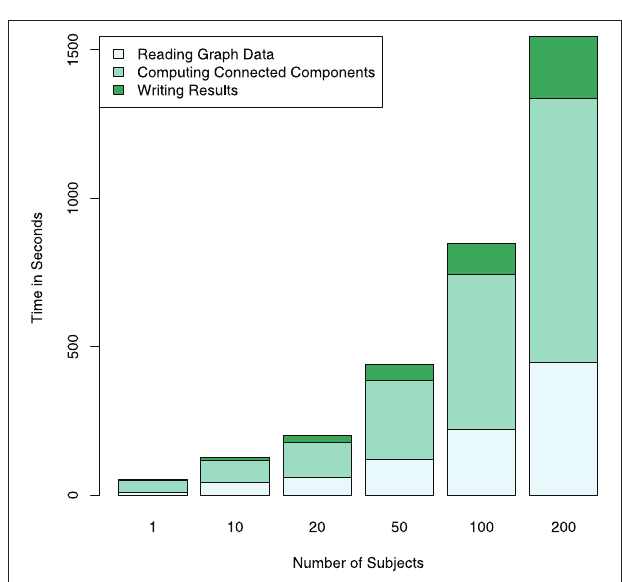
FIGURE 5 | Computation times for reading and writing the graph data in addition to computing connected components for a different number of subjects is shown performed on an Apache Spark cluster using four compute nodes. The largest part of the computation time is spent on the graph computations themselves. Note that the computational complexity of the search for connected components is relatively low ( O(n) ), in the case of more complex computations, the proportion of the total computation time spent with data I/O further decreases.